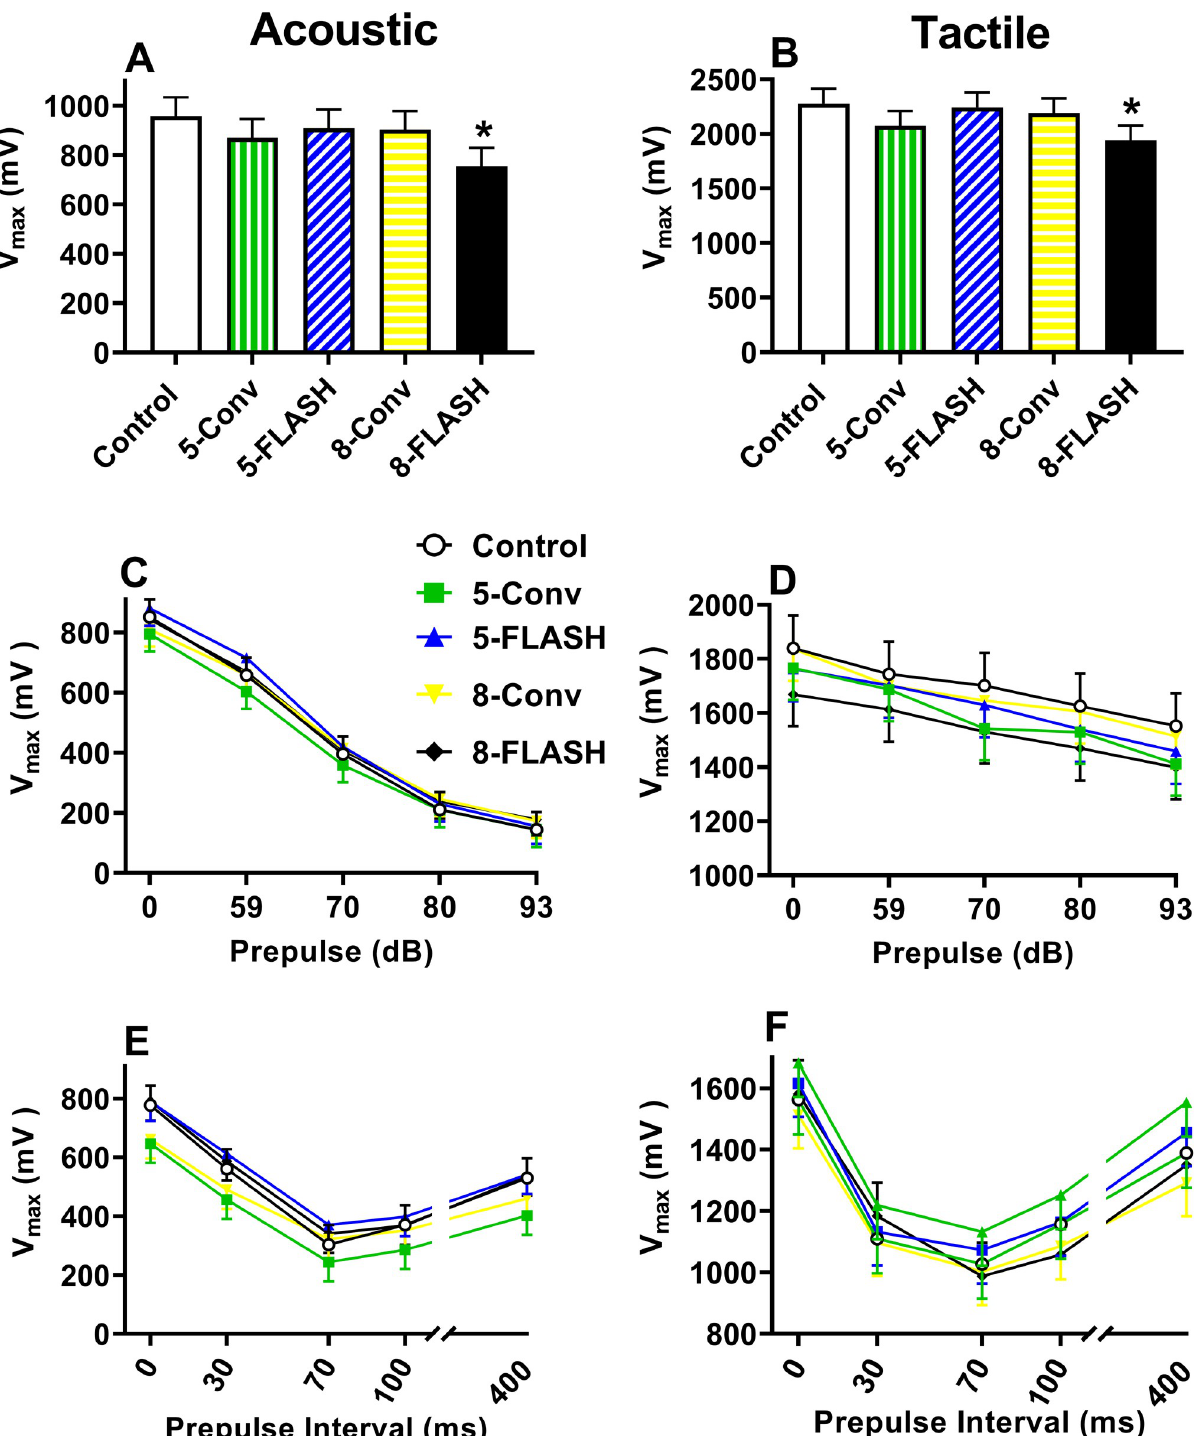
Fig 4. Acoustic or tactile startle responses [V max (mean ± SEM)] with or without acoustic or light prepulses. A . The effect on acoustic startle response by exposure, averaged across sex and days. The 8-FLASH group had reduced acoustic startle compared with controls. B . The effect on tactile startle response by exposure, averaged across sex and days. The 8-FLASH group had reduced tactile startle compared with controls. For panels A & B, N = 19/sex/exposure except Control and 5-FLASH males = 18/group. C. The effect of acoustic prepulses prior to an acoustic pulse by exposure averaged across sex. There were no differences between controls and irradiated groups. D. The effect of acoustic prepulses prior to a tactile pulse by exposure